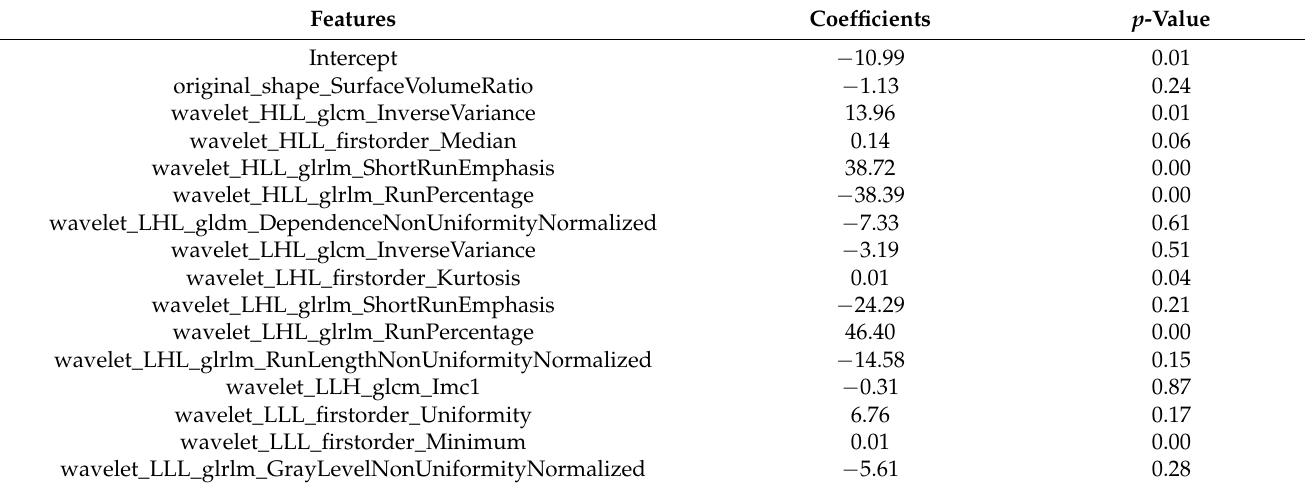
Table 5. Linear regression model